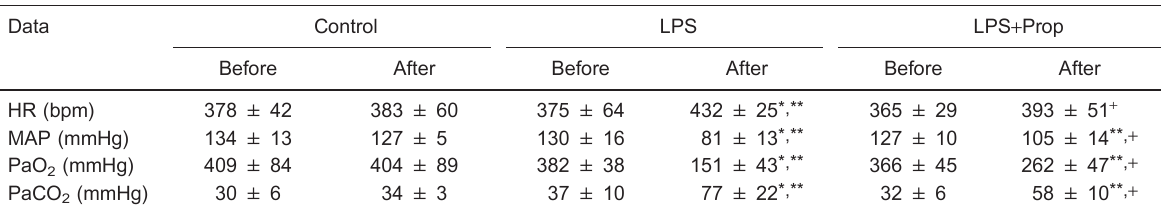
Table 2. Heart rate, mean arterial blood pressure, and blood gases of rats before intratracheal instillation and after 5 h of intratracheal instillation (n = 8).